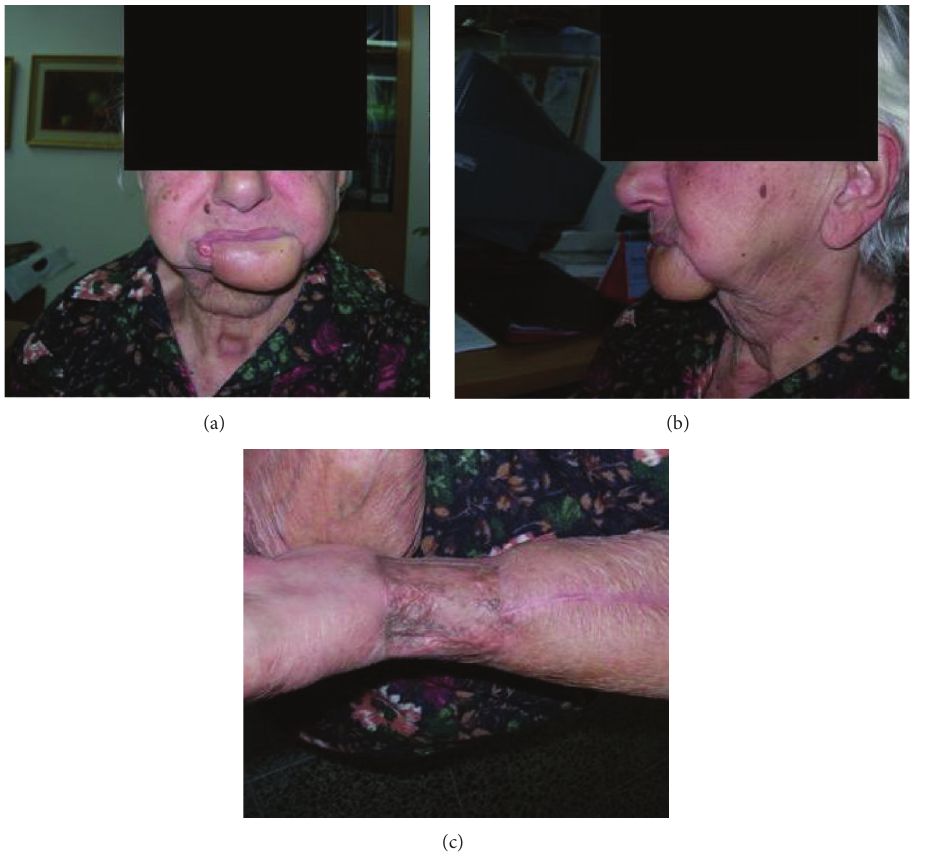
Figure 3: Patient number 2: result: (a) anterior view. (b) side view, and (c) donor site.